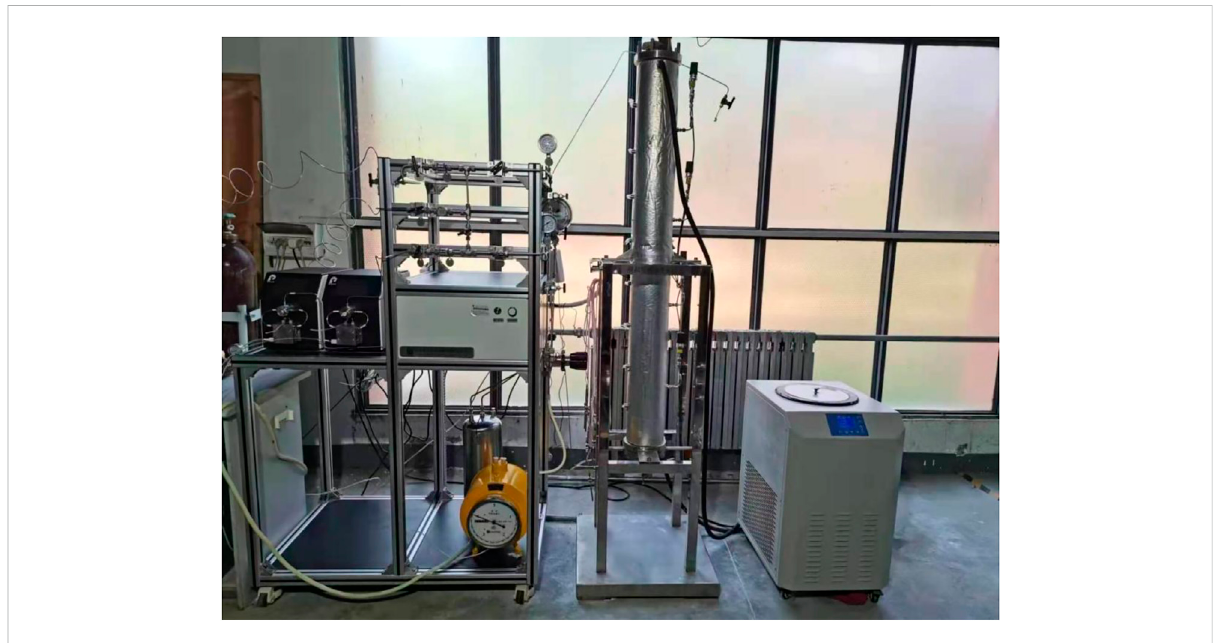
FIGURE 1 The picture of the experimental apparatus.